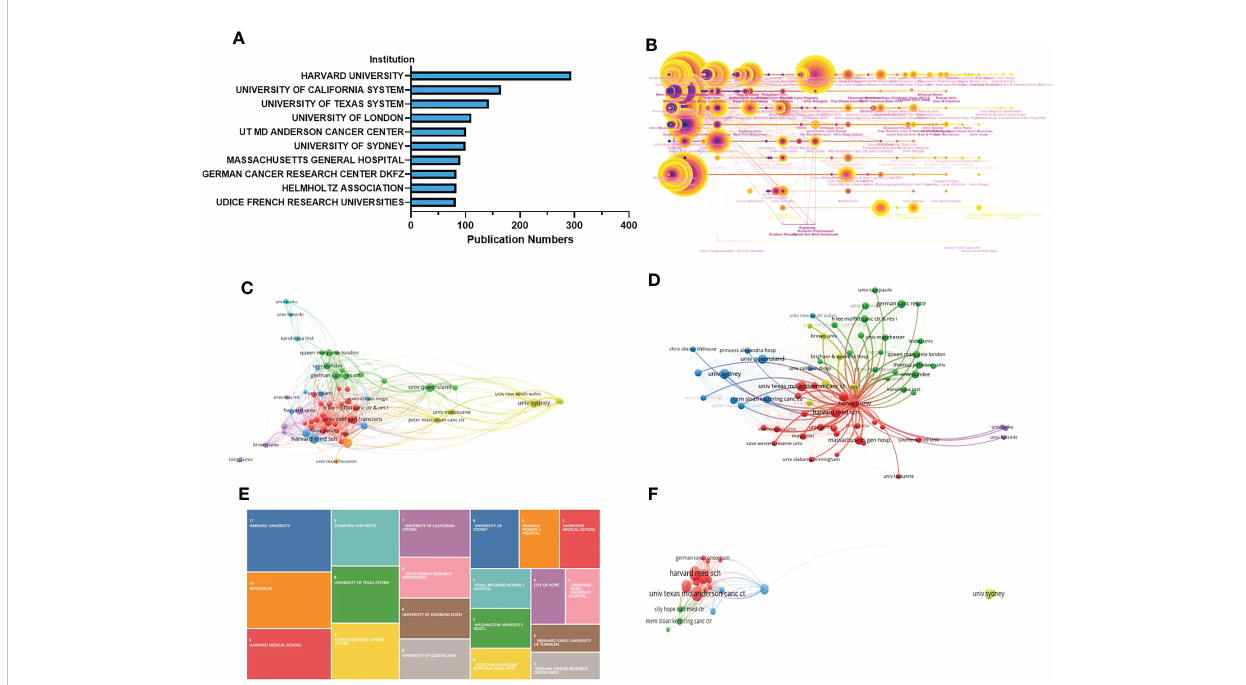
FIGURE 4 Literature analysis published by institutions. (A) . A statistical chart of the number of articles published by the top 10 institutions on CSCC research. (B) .Timeline and cluster view of all commonly referenced institutions. (C) .Excellent institutional coauthored analysis of the CSCC fi eld. (D) .Excellent institutional co-citation analysis in the CSCC fi eld. (E) .A statistical chart of the number of articles published by the top 20 institutions on CSCC cell programmed death studies. (F) .Excellent institutional coauthored analysis of the CSCC cell programmed death fi